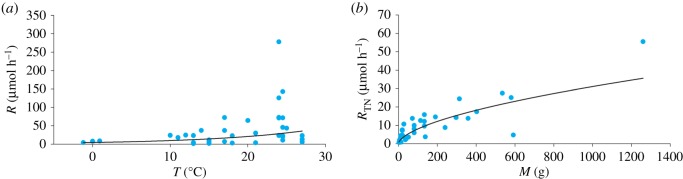
(a) Shallow-water holothurian metabolic rate (R) as a function of temperature (T). Shallow-water holothurian metabolic rate increases significantly with increasing temperature assuming an exponential function (solid line: R = 4.702 · e0.0750T; F1,36 = 8.796, p = 0.005, r2 = 0.196). (b) Shallow-water holothurian temperature-normalized metabolic rate (RTN) as a function of mass (M). Metabolic rate data were normalized to a temperature of 2.5°C using a shallow-water-holothurian-derived Q10 of 2.12. Shallow-water holothurian metabolic rate increases with increasing mass assuming a power function (solid line: RTN = 0.5436 · M0.5858; F1,36 = 103.000, p < 0.001, r2 = 0.741). Data from [13,28–41].